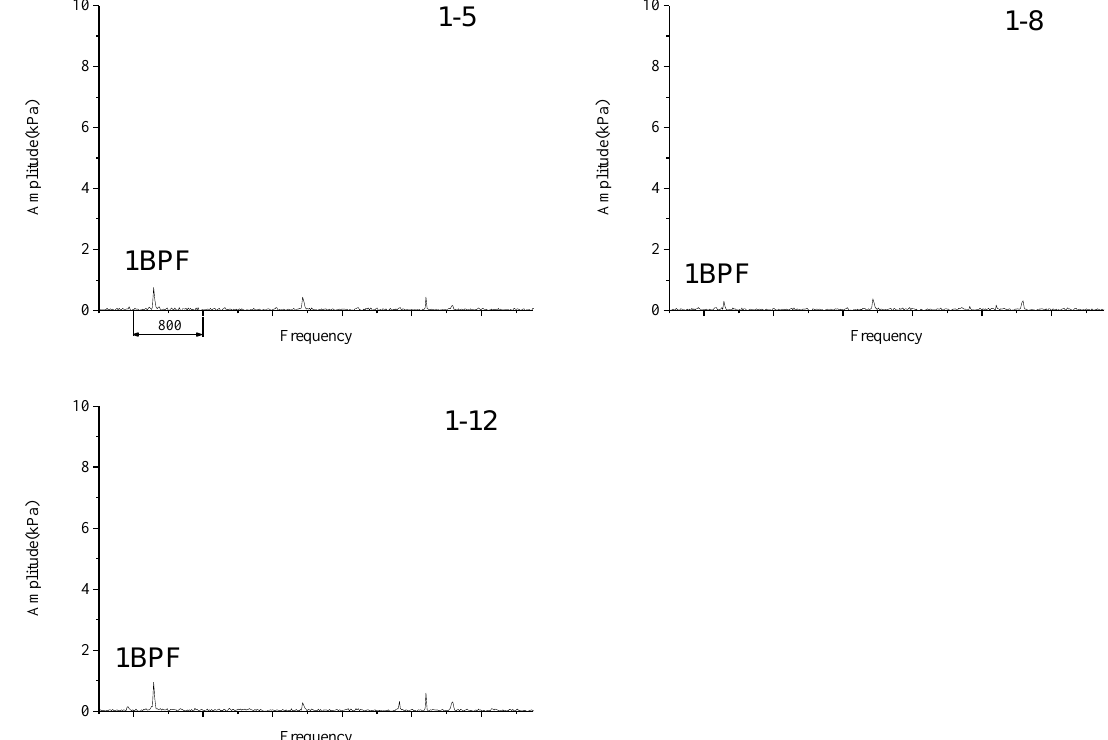
Figure 25 . Changes in the pressure frequency spectrum inside R1, at the surge limit .